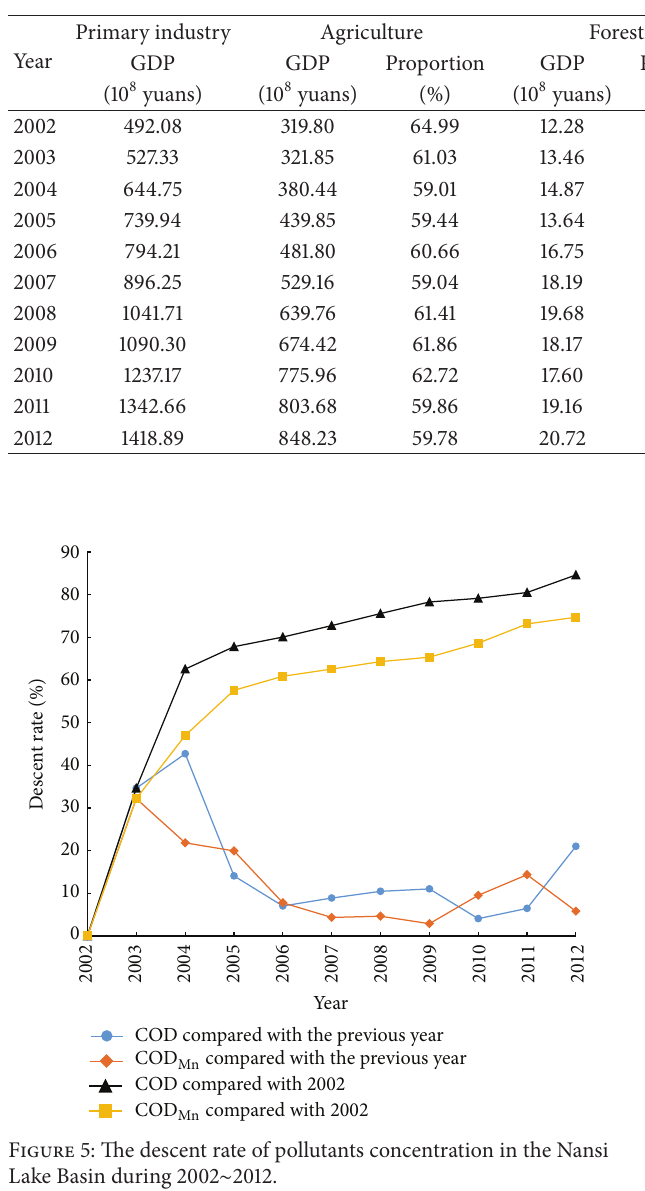
Table 1: The basic situation of primary industry in the Nansi Lake Basin from 2002 to 2012.